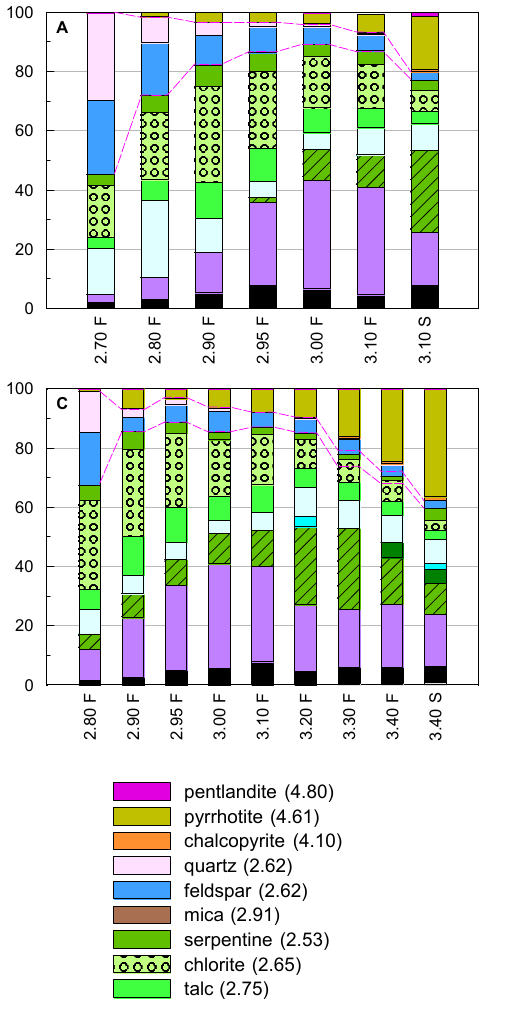
Figure 4. Bulk mineralogy of the DMC feeds as determined by QXRD, with average SGs given in brackets. The Fe-Ti oxides grouping includes magnetite, hematite, chromite, ilmenite and rutile.